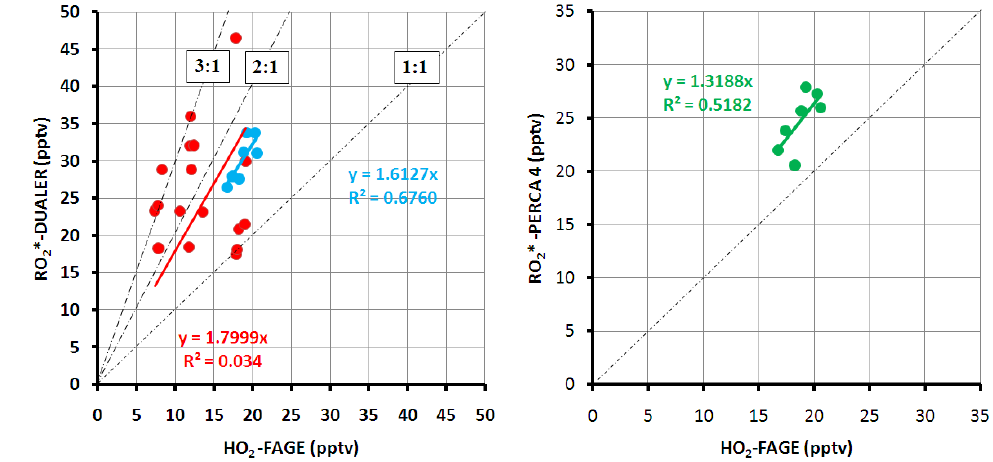
Fig. 9. [RO ∗ ]/[HO 2 ] ratio measured during the AMMA intercomparsion exercise. In blue and green are the data corresponding to the first pressure level measured (697hPa).